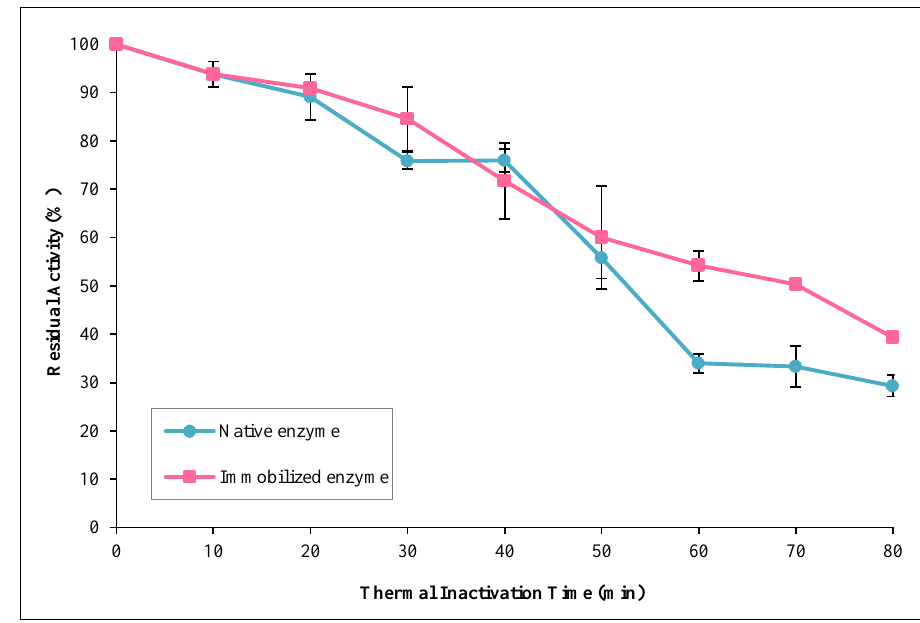
Figure 6. Thermal stability of the native and immobilized enzymes (mean ± SD; n = 2; p < 0.05). The data were determined at optimum temperature and starch concentration. The initial enzyme activity was assuming 100% Table 3. Thermal stability of A. fumigatus α-amylase immobilized on different